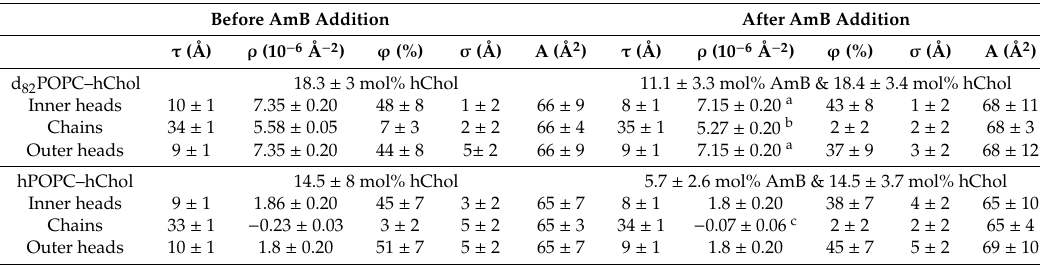
Figure 3. Neutron reflectivity data and the corresponding neutron scattering length density profiles of d 82 POPC–hChol ( a , c ) and hPOPC–hChol ( b , d ) bilayers measured in different solvent contrasts at 30 ◦ C before (open symbols / dotted lines) and after (solid symbols / lines) addition of 1mM of AmB. A schematic illustration of the membrane structure and location of cholesterol and AmB corresponding to the fits is presented over the SLD profile ( c , d ). Table 4. Parameters corresponding to the best fits to the data from POPC–cholesterol bilayers before and after AmB addition, as displayed in Figure 3.